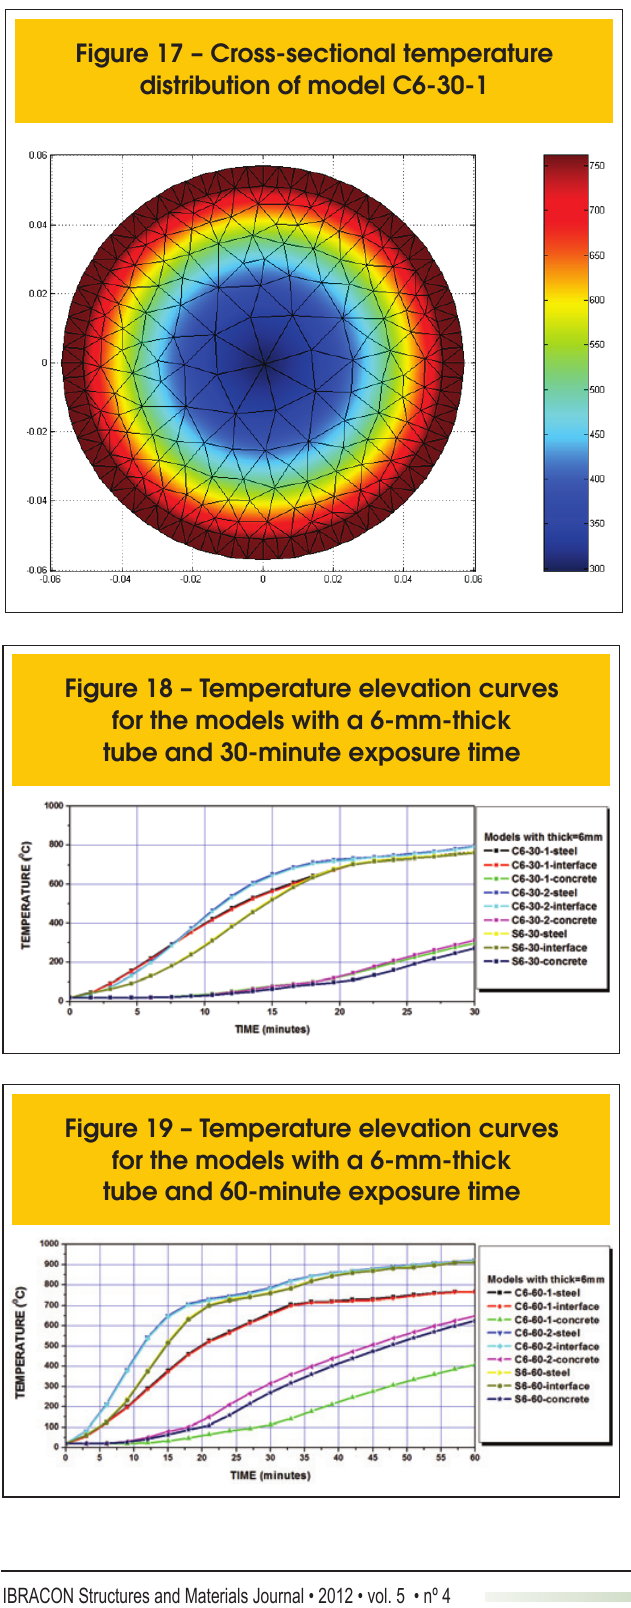
Figure 17 – Cross-sectional temperature distribution of model C6-30-1